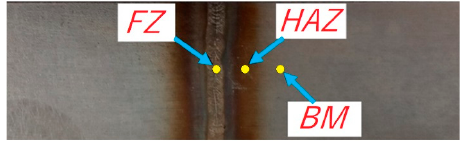
Figure 1. Zones for the measurement of residual stress.